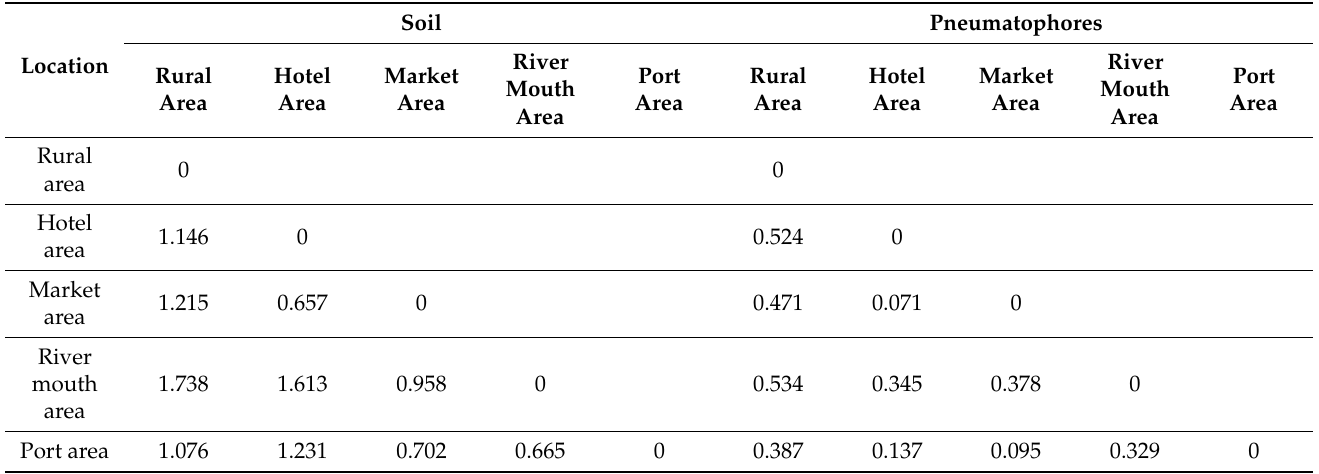
Table 1. Distance values between centroids of soil and pneumatophore samples from five mangrove areas in Bima City